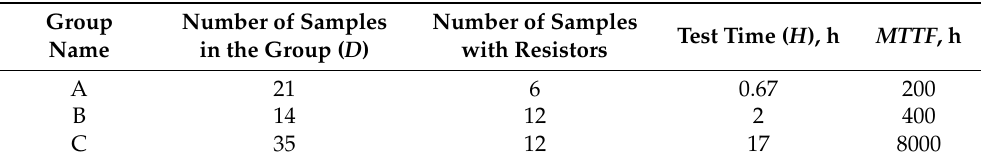
Table 1. Results of accelerated life test of structural electronics circuits. The test was conducted in 344 K (71 ◦ C), where the assumed use temperature was 294 K (21 ◦